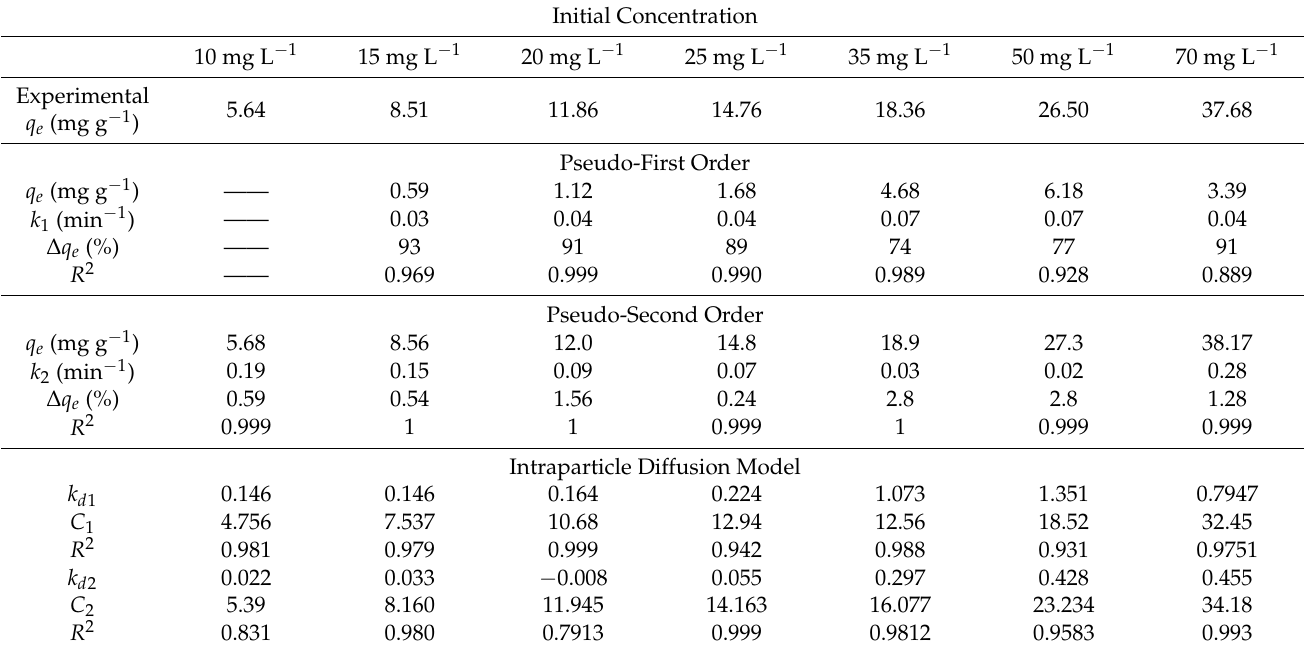
Table 2. Adsorption kinetic parameters of CPX onto F Zn (adsorbent doses: 1.6 g L − 1 , pH: 5 to 6; contact time: 60